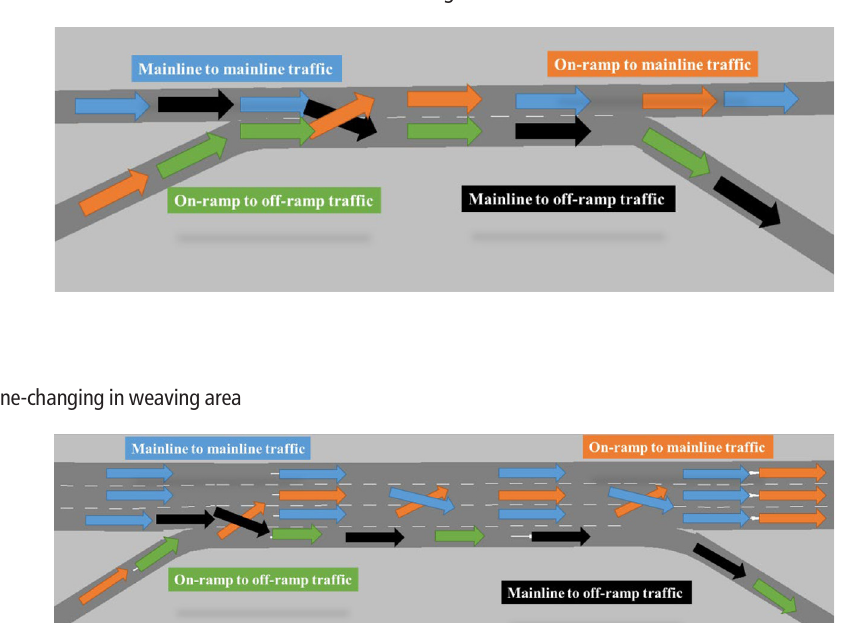
Figure 3 Behavior of two lanes with different fl ow directions in the weaving